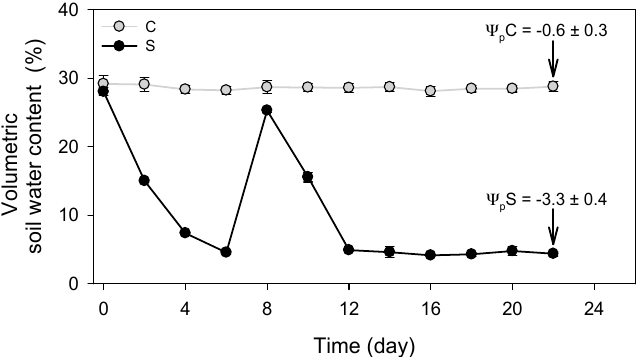
Figure 2. Evolution of volumetric soil water content throughout the water stress period for Quercus suber control (C) and water stressed (S) seedlings. Data are mean ± SE of all populations. We confirmed that volumetric soil water content was the same for all populations because no significant differences were found among populations. Arrows show the day on which pressure-volume curves were determined. In this date, predawn water potential ( Ψ p , MPa) mean values ( ± SE) are also shown for both C and S seedlings.